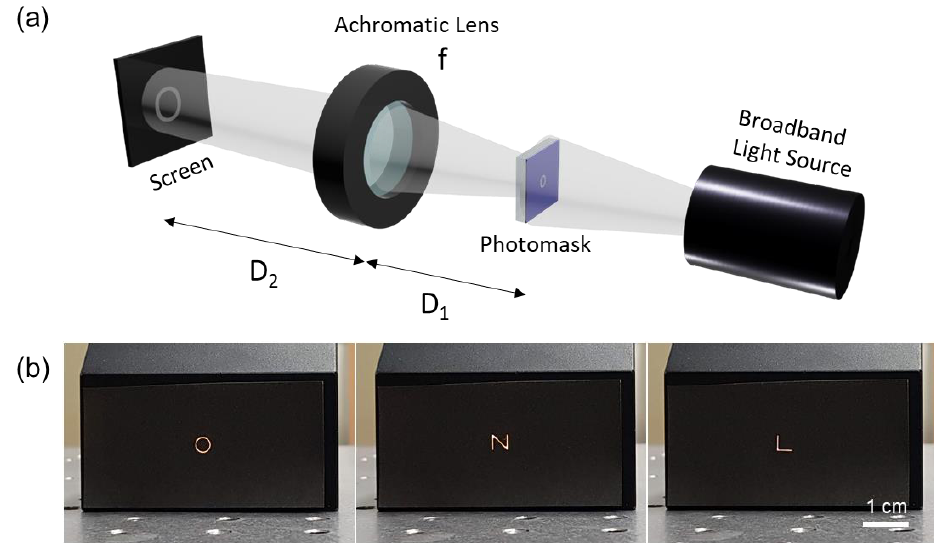
Figure 5. ( a ) Schematics for the optical setting for the reproduction of the void pattern created on the Ag NP layer by the proposed technique. (f = 100 mm, D 1 = 150 mm, D 2 = 300 mm); ( b ) Photographs of the Alphabetic letters (‘O’, ‘N’ and ‘L’) reproduced on the screen.